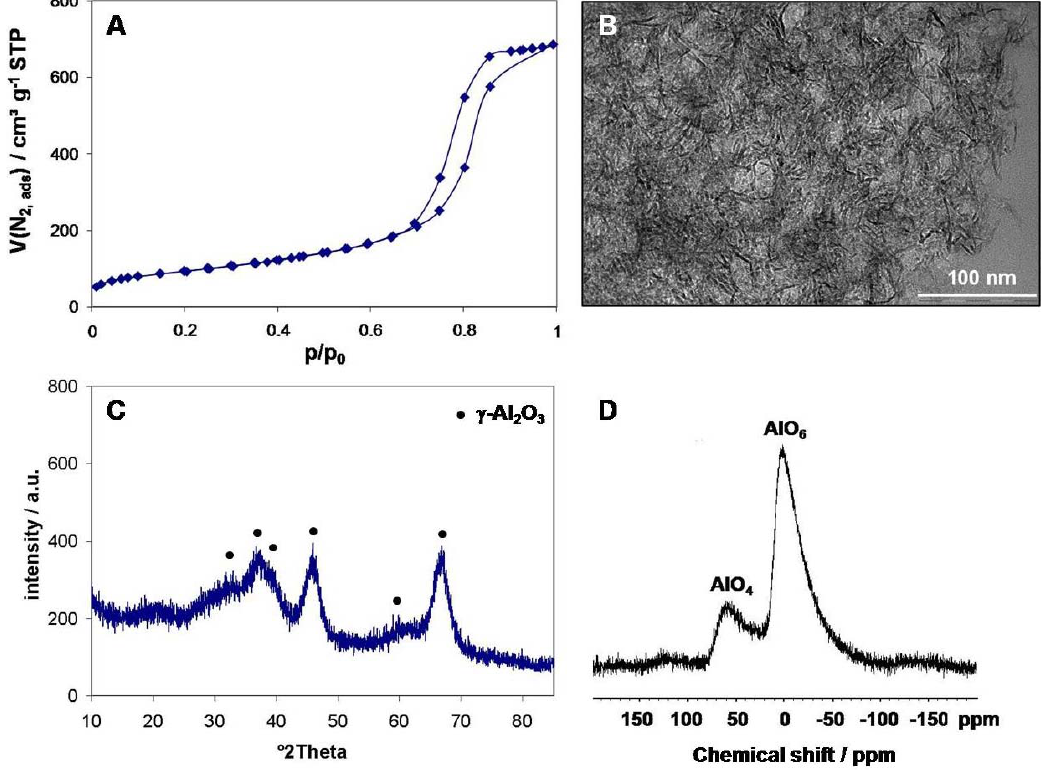
Figure 4. ( A ) Nitrogen sorption isotherms at 77 K of mesoporous disordered γ -Al calcined at 500 °C; ( B ) TEM image showing the fibrillar morphology of the material; ( C ) XRD pattern showing the peaks assigned to the γ -Al spectra for which penta-coordinated Al sites are absent as expected for a crystalline alumina